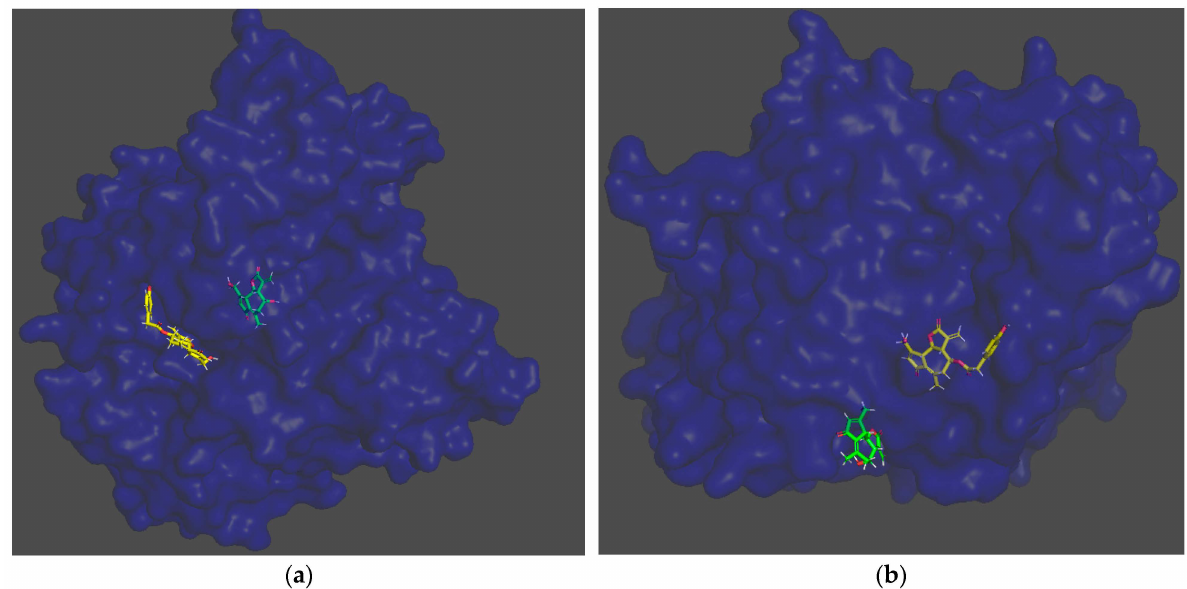
Figure 4. Docking simulation results. Three-dimensional models of positions in AChE pockets: ( a ) lactucin and lactucopicrin (the priority for docking was established for lactucin); ( b ) lactucopicrin and lactucin (the priority for docking was established for lactucopicrin). Chain markings: green— lactucin,